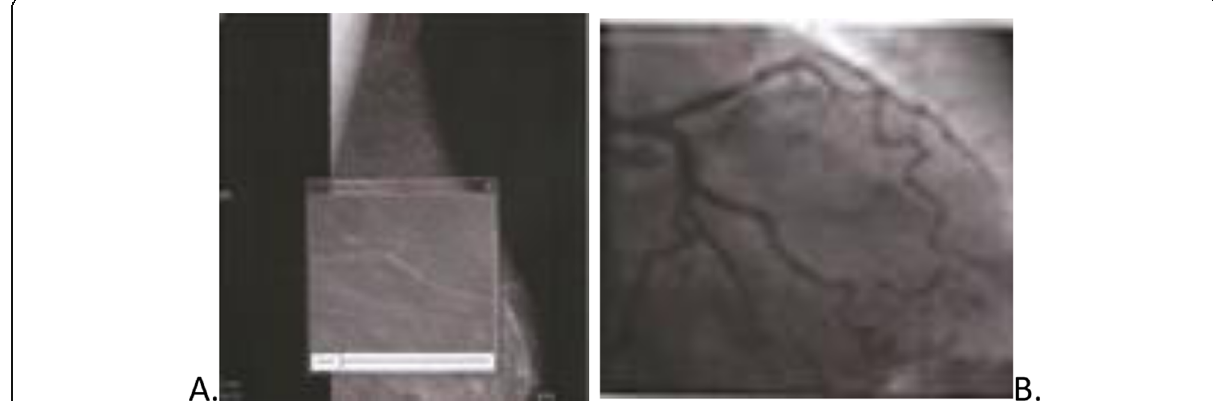
Fig. 3 a 56-year-old female patient known DM and HTN. Her cardiac catheterization was normal MLO mammography view showing faint BAC. b Showing normal cardiac catheterization image in patient with risk factors and old